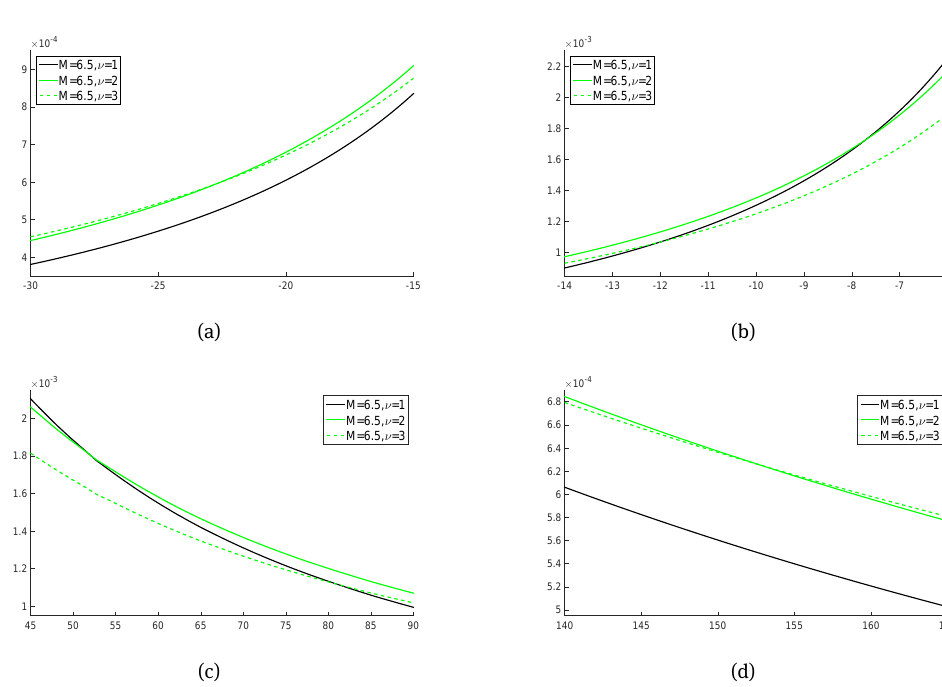
if p ∈ (cid:8) 1 2 , 1, 2, 3 (cid:9) . PE